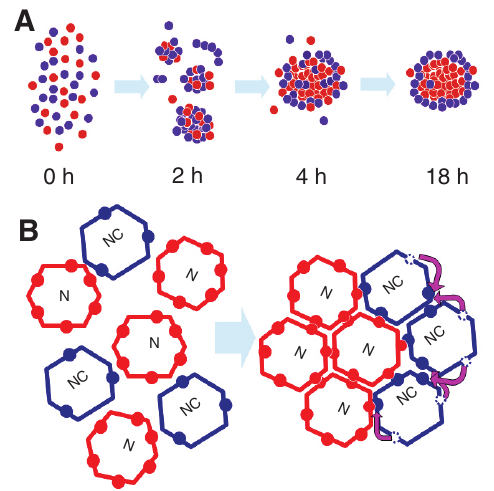
Figure 10. Scheme of ENS neuron (red) and ENC (blue) aggregation. A . Initially ENC cells and neurons cohere in a disorderly fashion (2–4 h) but gradually the neurons sort out to a central position (18 h), indicating neurons have a greater adhesive bond energy. B . Neurons and ENC cells have adhesive molecules (coloured circles) which are free to move in the cell surface, but the neurons have more adhesive molecules. Cell-cell adhesion requires juxtaposition in trans of two adhesive molecules (red-red, blue-blue or red-blue). To minimise adhesive free energy, adhesive molecules on ENC cells move (pink arrows) in order to form an adhesion, thereby denuding the outer face of adhesion molecules. This insulates the group from further